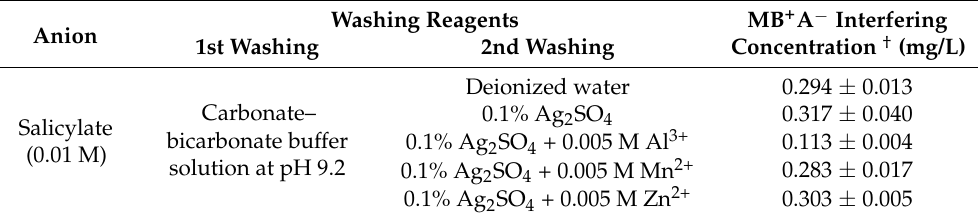
Table 7. Effects of first and second washing reagent on the interferences by salicylate.